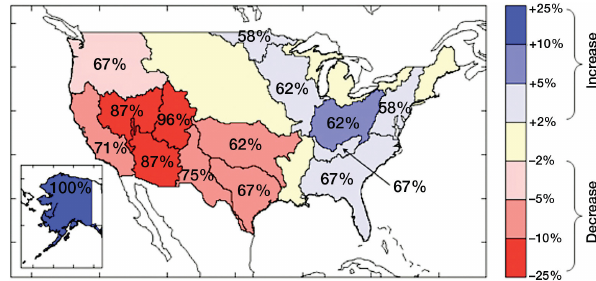
Fig. 12 . Median changes in runoff interpolated to USGS water resources regions from Milly et al. (2005) from 24 pairs of GCM simulations for 2041-2060 relative to 1901-1970. Percentages are fraction of 24 runs for which differences had same sign as the 24-run median. Results re-plotted from Milly et al. (2005) by Dr. P.C.D. Milly, USGS. From Backlund, et al., 2008.